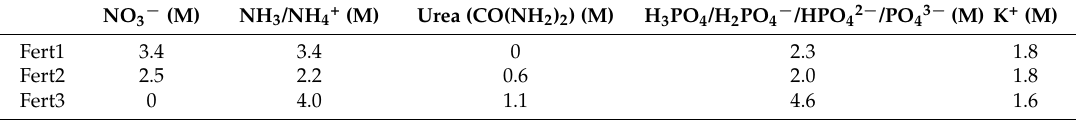
Table 1. Molar concentration (mol/L) of the NPK components in the tested fertilizers, according to the declared compositions. No information about the non-NPK components was provided by the